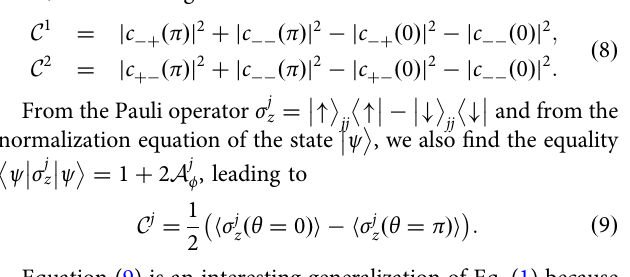
Fig. 1 Topological phase diagrams. a Spin-1/2 model: topological phase = H ; ~ r = H Þ plane where M fi eld on diagram for each spin in the ð M 2 is the bias 2 the second qubit, ~ r is the interaction, and H is the radial magnetic fi eld. Lines demarcate regions of different partial Chern numbers. Here, we have set the bias fi eld for the fi rst qubit to M 1 = H /3. The gold line at M 2 = M 1 indicates the symmetric phase with partial Chern numbers C 1 ¼ C 2 ¼ 1 . The 2 insets illustrate (adiabatically deformed) spheres corresponding to the parameter space spanned by the effective fi eld for spin 1 (blue) and spin 2 (orange) in each phase. The topological charge at the origin is indicated by the red dot. Along the gold line the effective- fi eld manifold (which is identical for each spin) is in a coherent superposition of containing and not containing the monopole yielding a Chern number of 1/2 for each spin. b Lattice model: topological phase diagram in the ( M 2 , r ) plane for the total Chern number at half- fi lling, de fi ned with the two lowest occupied bands. Here, M 2 refers to the Semenoff mass in layer 2 and r is the interlayer hopping. The gold line at M 2 = M 1 indicates the symmetric phase for which the gap is closed. t 1 is the nearest-neighbor hopping amplitude, and j d z j ¼ ffiffiffi p t 3 3 2 is the next-nearest-neighbor amplitude at the Dirac